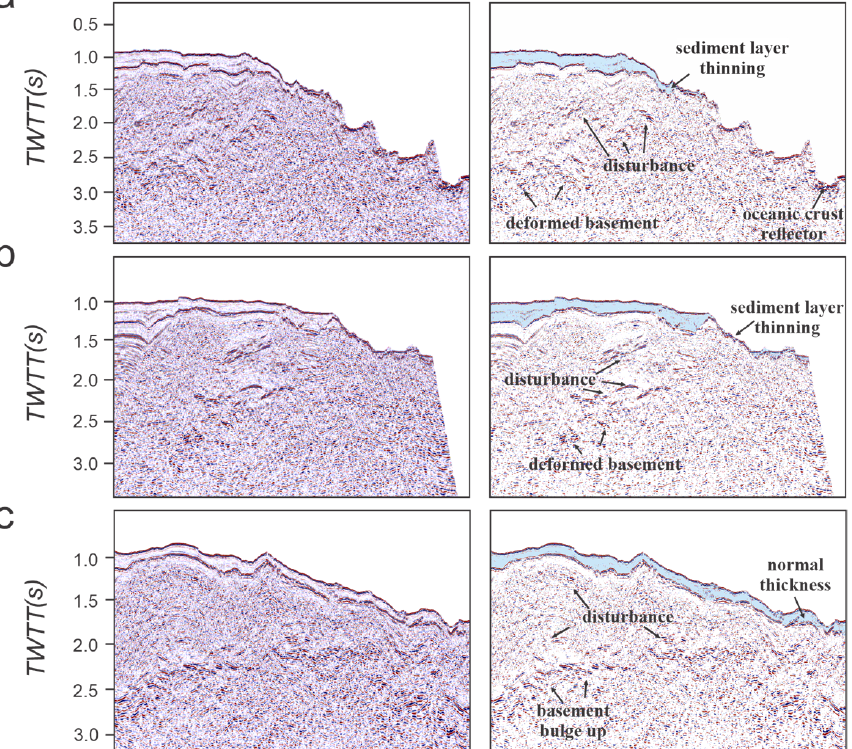
Figure 7. Deformed zones. Indicators of regional uplift: deformed basement, interrupted Pliocene– Pleistocene sediments, and disturbances within the evaporite deposition. Differential crustal vertical movement between the axial deep and the inter-trough zone. ( a ) Profile 060. ( b ) Profile 054. ( c ) Profile 050.